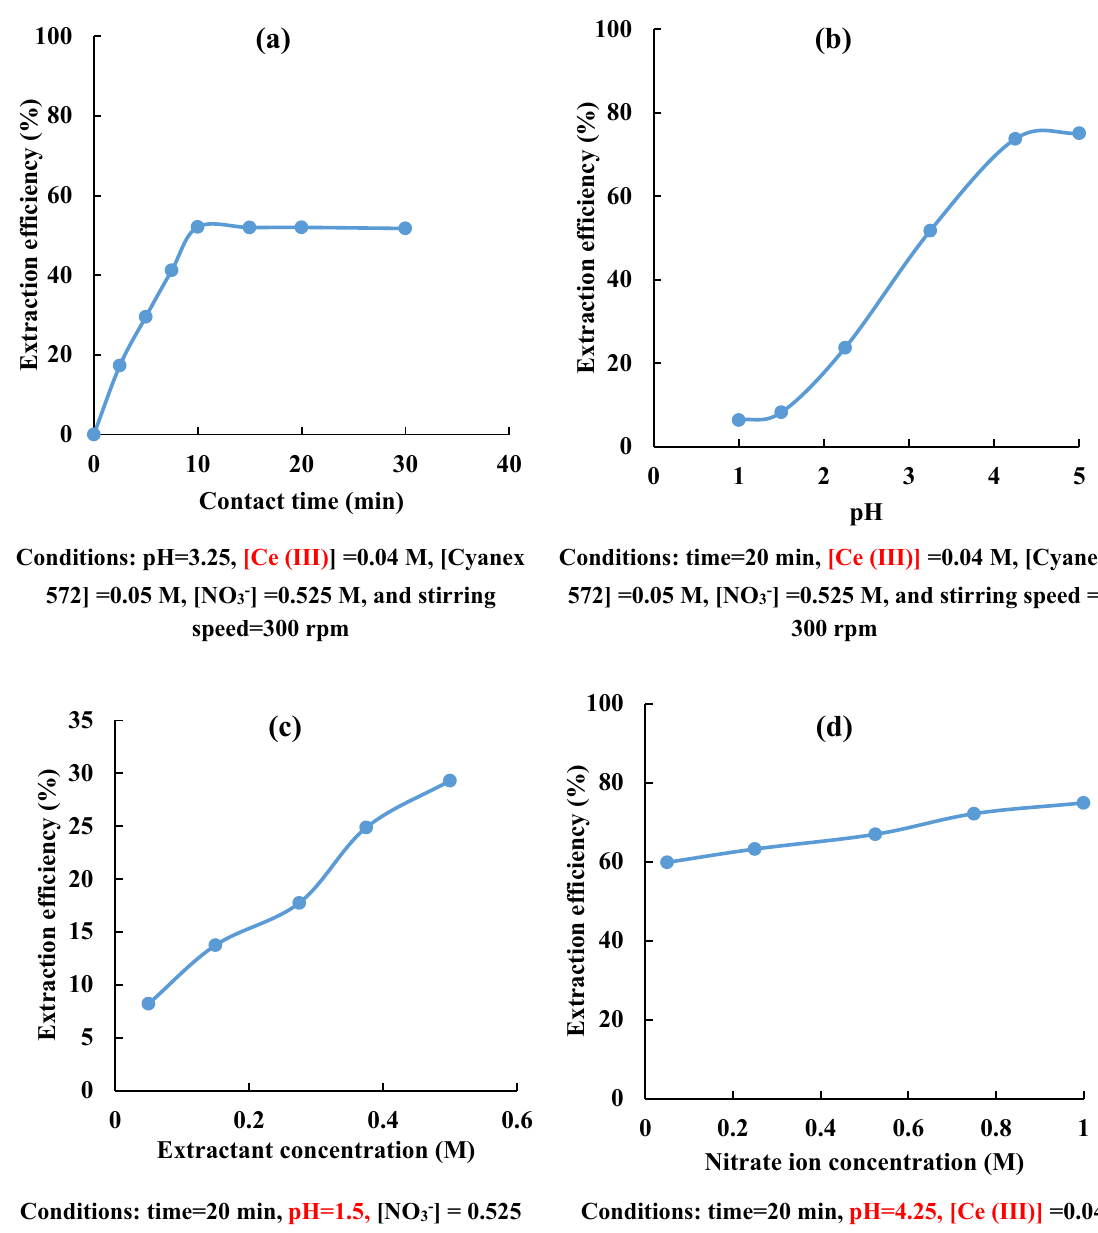
Figure 2. Effect of ( a ) contact time, ( b ) pH, ( c ) extractant concentration and ( d ) nitrate ion concentration on the cerium extraction